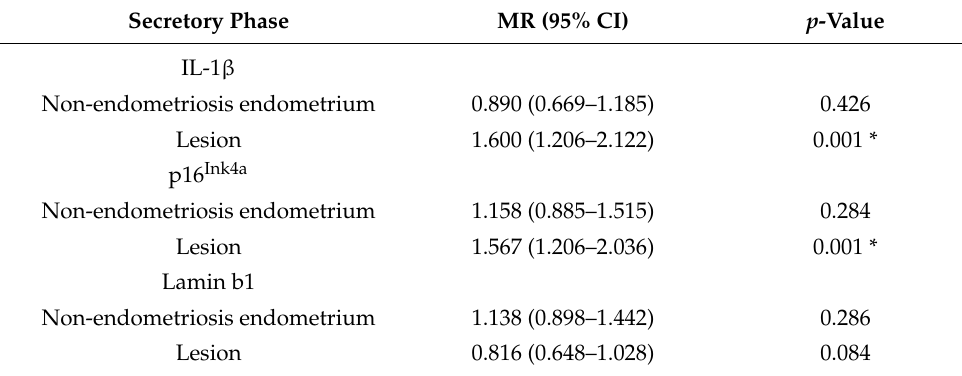
Table 2. Protein expression (p16 Ink4a , lamin b1, and IL-1 β ) according to tissue type (control en- dometrium, eutopic endometrium, and endometriosis